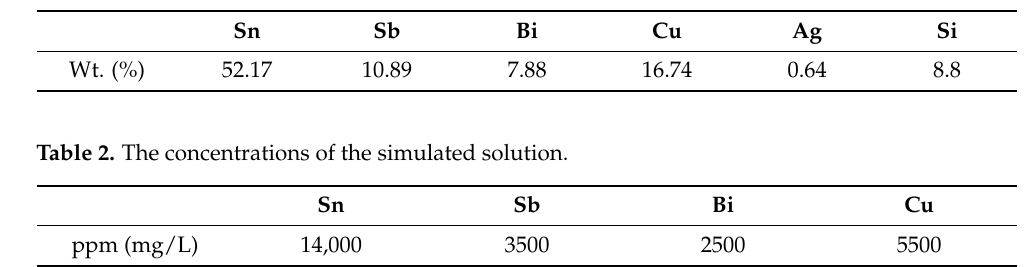
Table 1. The components of tin anode slime.